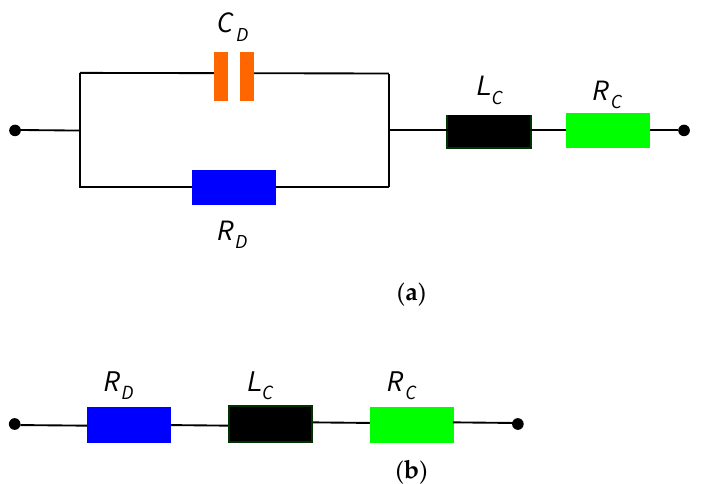
Figure 8. Equivalent circuit of the FTJ-based microwave switch when ( a ) the FTJ is in its reverse polarization state (a negative DC polarity is applied) and ( b ) the FTJ is in its forward polarization state (a positive DC polarity is applied).